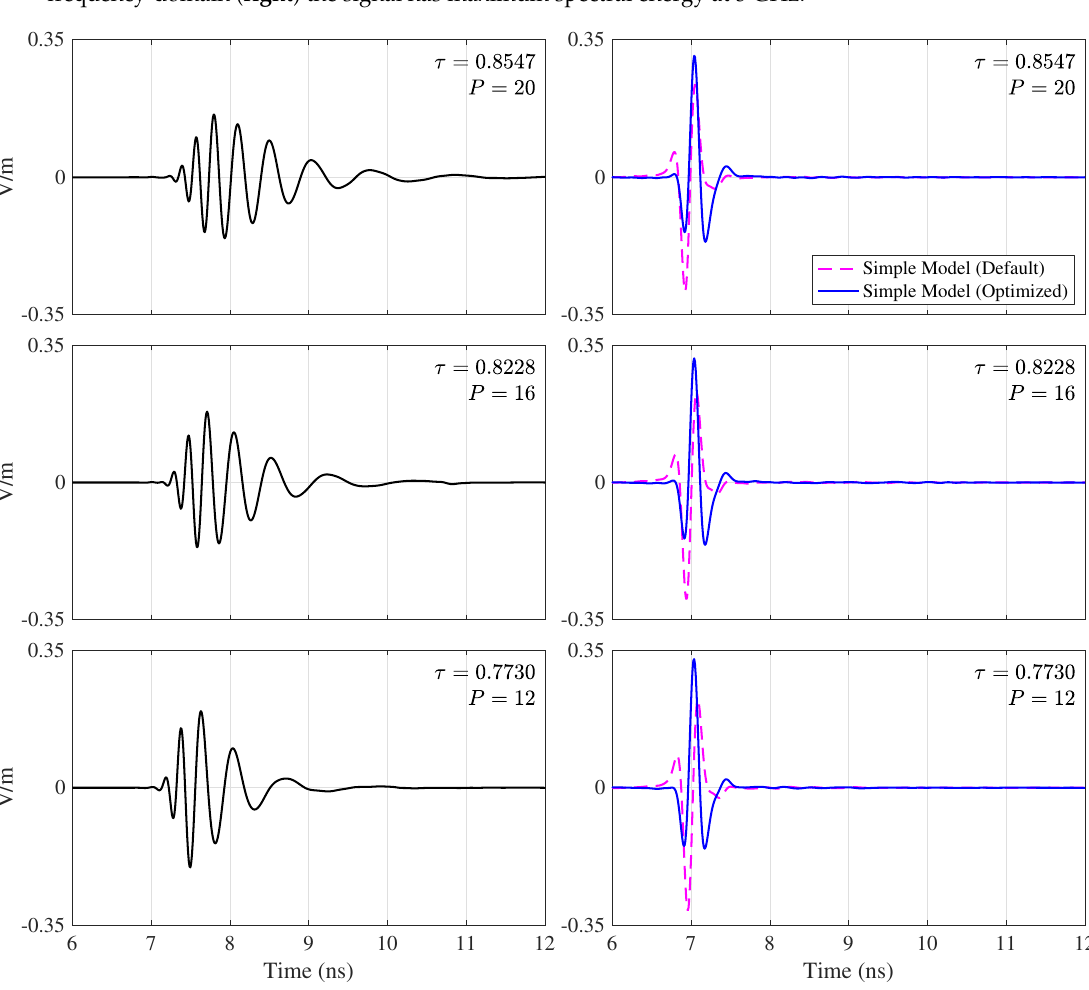
Figure 8. Dispersed radiated pulses at 2 m on boresight ( left ), and the corrected radiated pulse at 2 m on boresight after the simple antenna dispersion model has been applied ( right